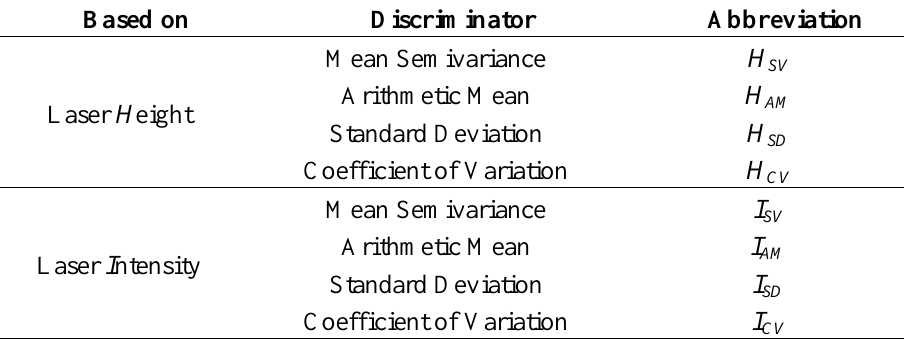
Table 2. Geostatistical and statistical measures used for